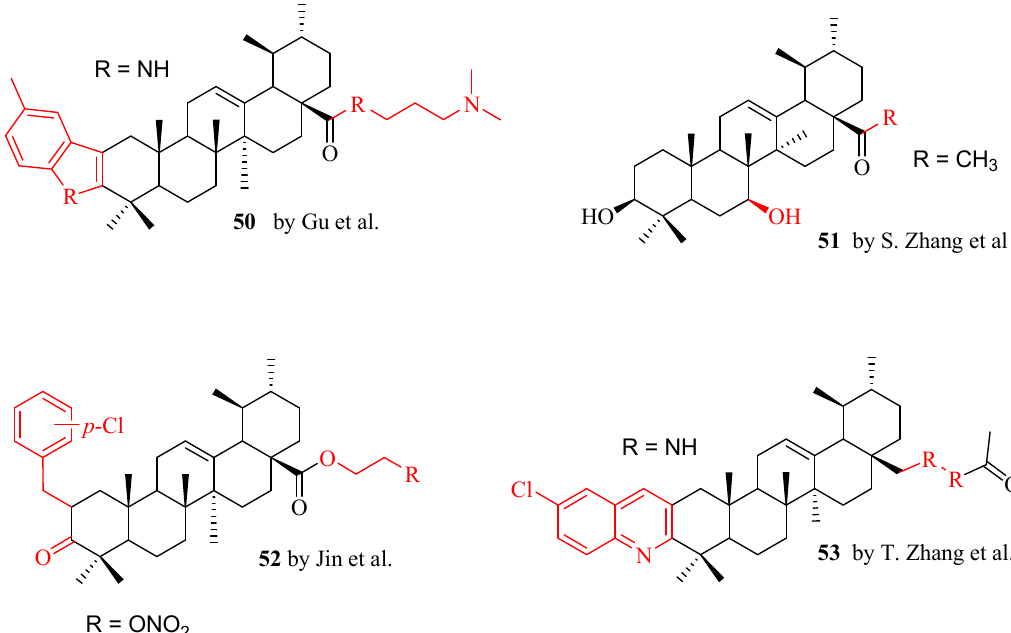
Figure 4. Gu’s, S. Zhang’s, Jin’s and T. Zhang’s work on UA derivatives.